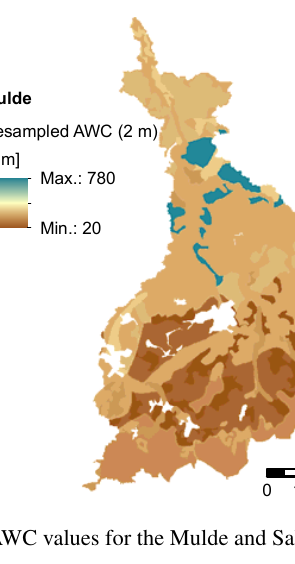
Figure 11. AWC of the Salzach catchment and the distance-factor function of σ U (C) and σ S (C) . Red marked and numbered areas incorpo- rating high-value enclosures.